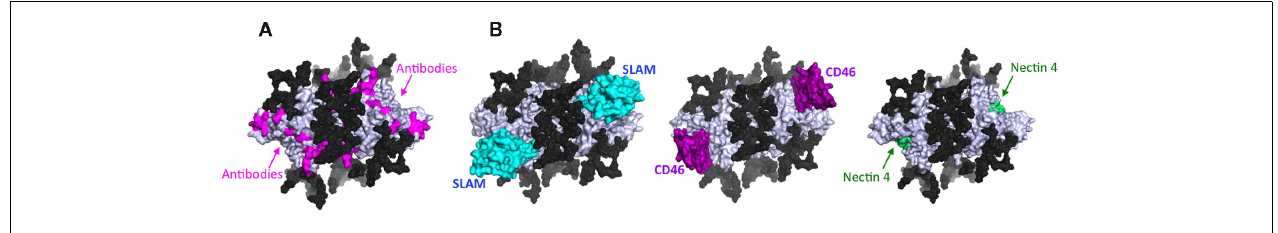
Left, crystal structure of MV-H–SLAM (SLAM shown in cyan). Middle, crystal structure of MV-H–CD46 (CD46 in purple). Right, putative nectin-4 binding sites (green), based on site-directed mutagenesis of